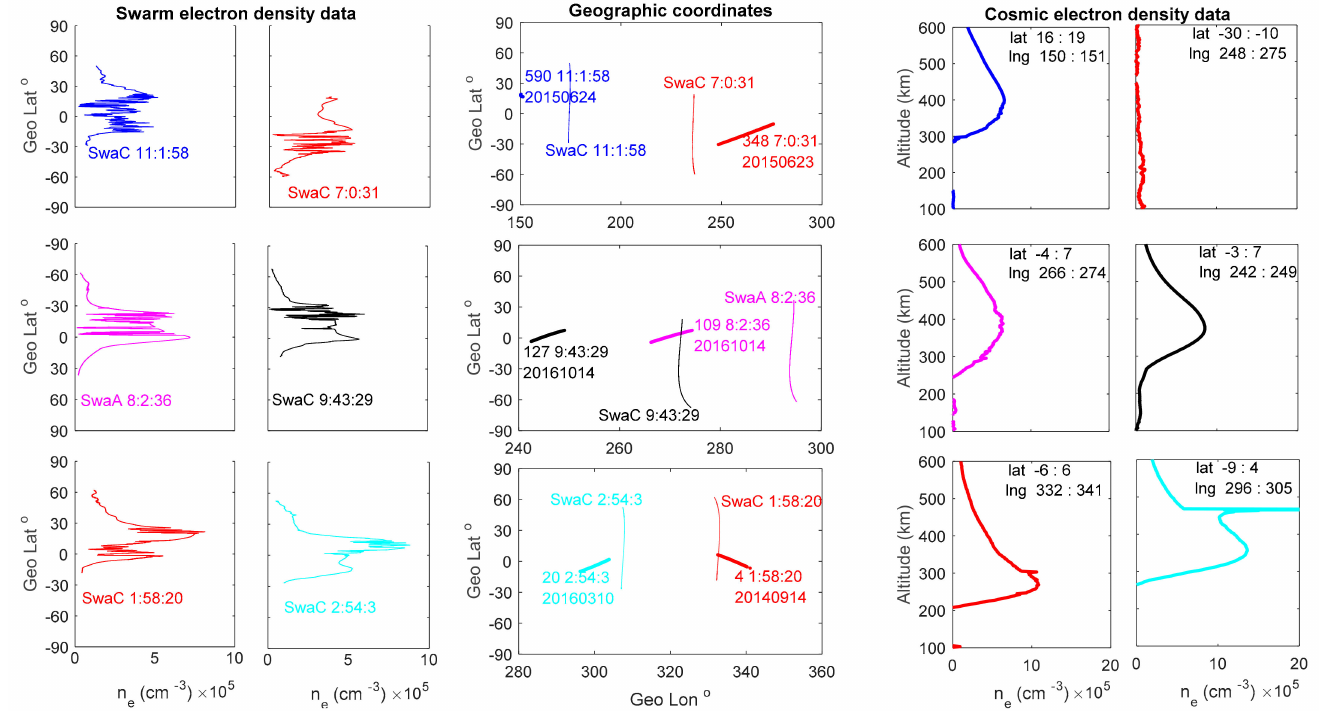
Figure 9. The n e profiles during super, intense, and moderate geomagnetic storms are shown in the rows from top to bottom, respectively. The middle column shows the geographic coordinates of the Swarm and COSMIC satellites, while the left and right columns correspond to n e data observed by Swarm and COSMIC satellites,